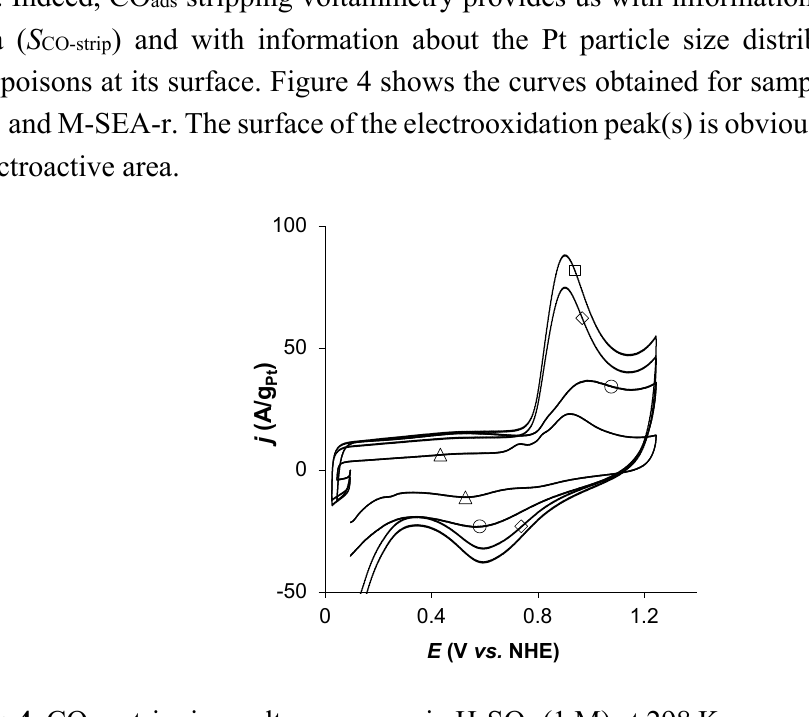
Figure 4. CO ads stripping voltammogram in H 2 SO 4 (1 M) at 298 K; sweep rate of 0.020 V/s. (  ) WI-R; (  ) M-SEA-473; (  ) M-SEA-723; (  )